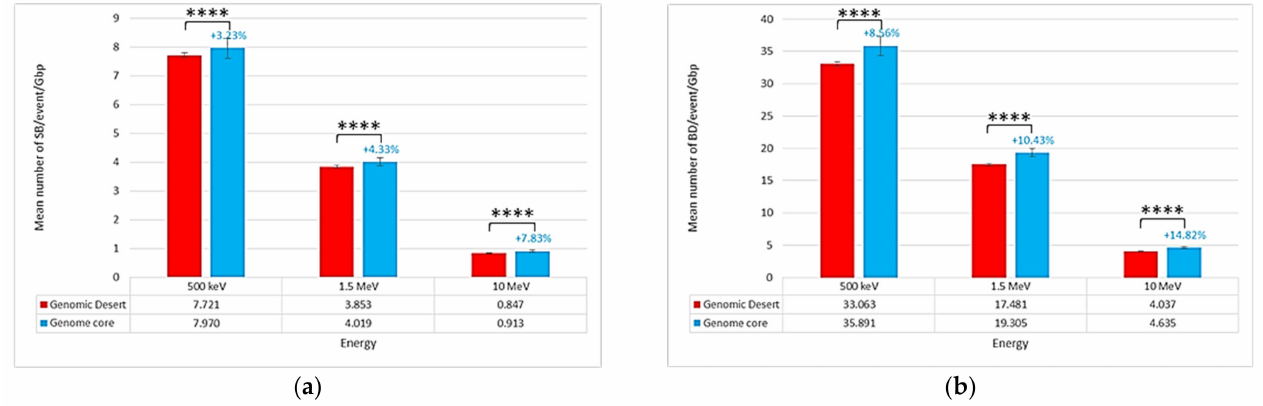
Figure 4. Location of the simulated damage produced by proton ( a ) SBs/event/Gbp and ( b ) BDs/event/Gbp. For the genome core, the figures above the bars indicate the relative increase compared to the genomic desert in the mean number of ( a ) SBs/event/Gbp and ( b ) BDs/event/Gbp. Asterisks above the bars represent the degree of confidence on the difference between the two related mean values assessed by the Mann–Whitney U-test (**** p < 0.0001).